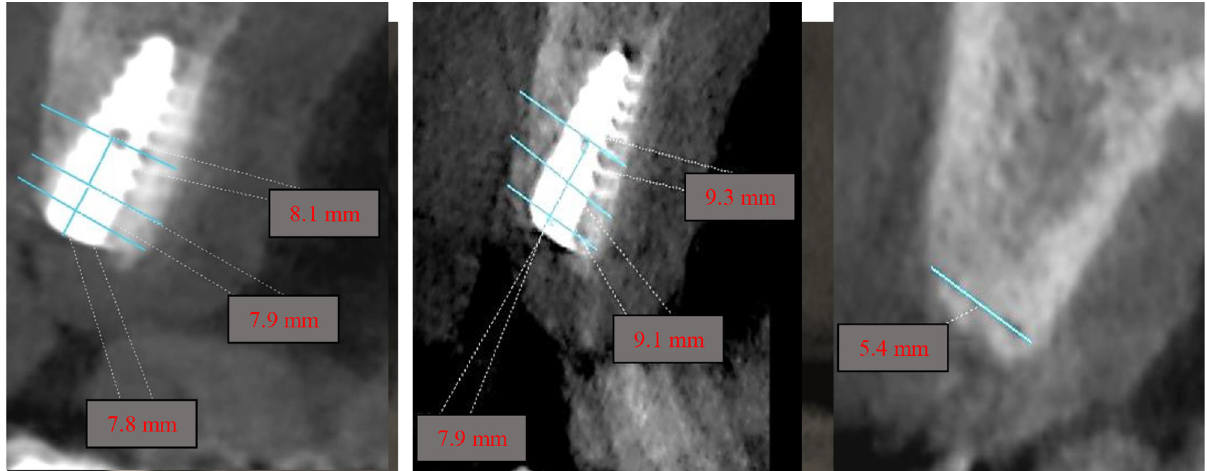
Fig. 1. Radiographic evaluations to show the overall width at T0, T1, T2 times.